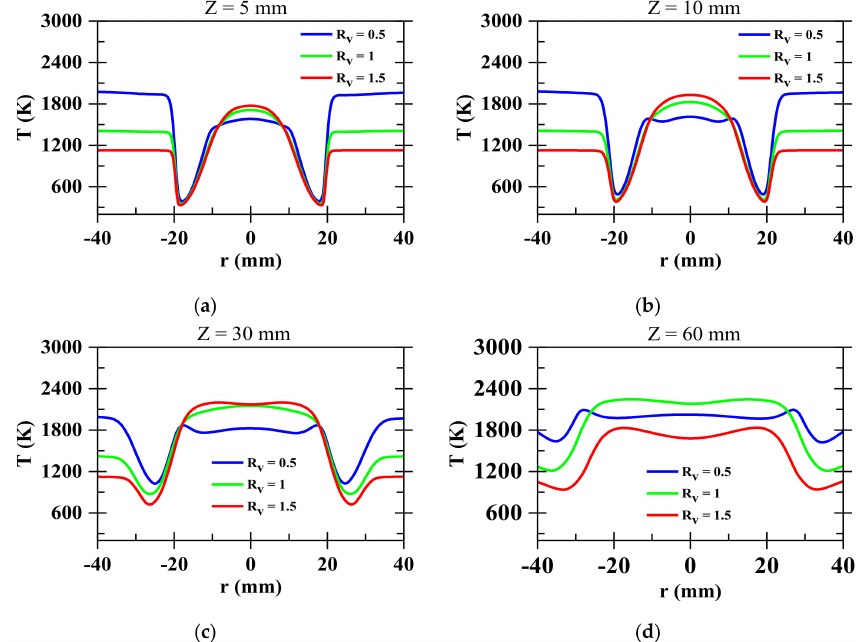
Figure 10. Computed temperature profiles for three velocity ratios obtained at four heights; ( a ) Z = 5 mm; ( b ) Z = 10 mm; ( c ) Z = 30 mm; ( d ) Z = 60